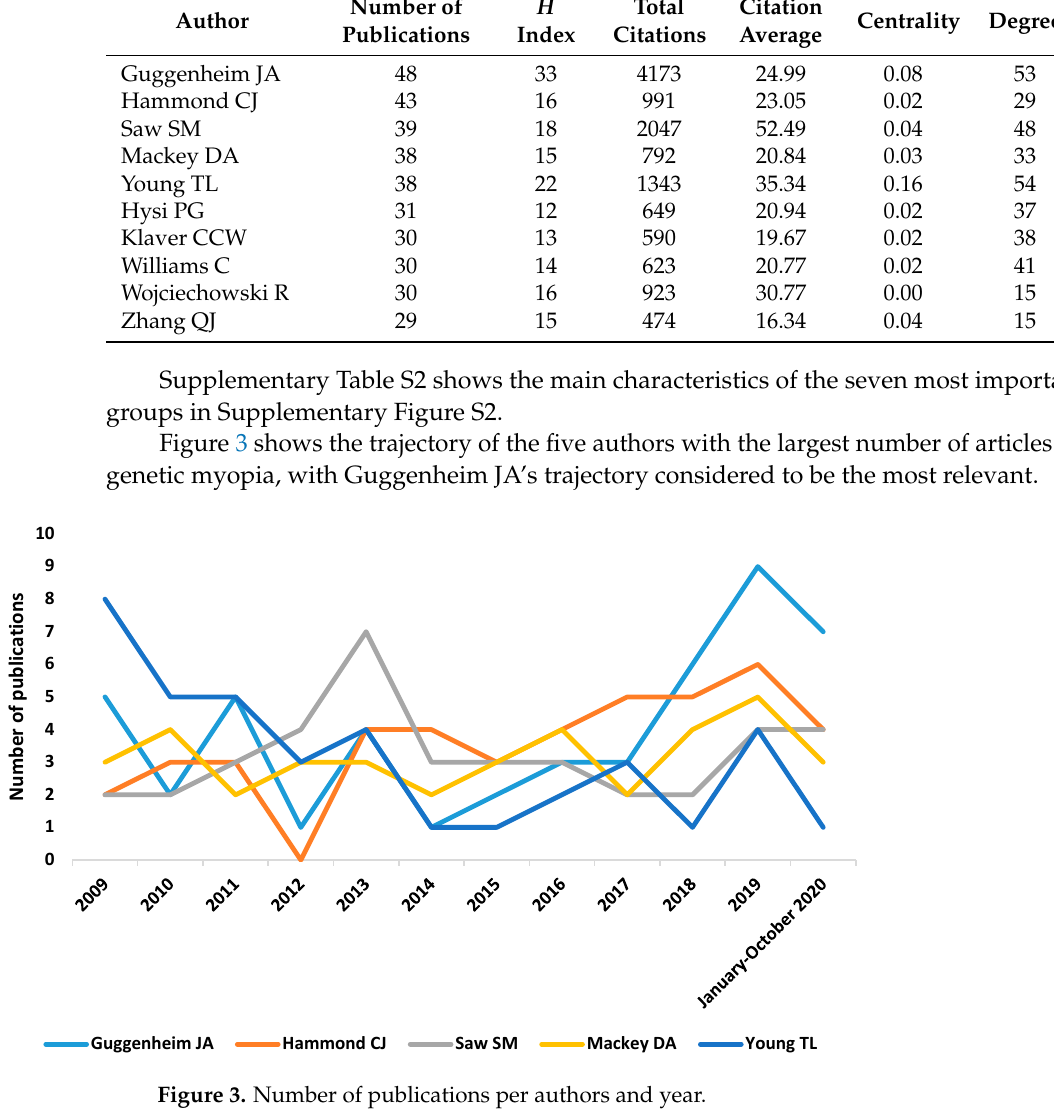
Figure 3. Number of publications per authors and year.